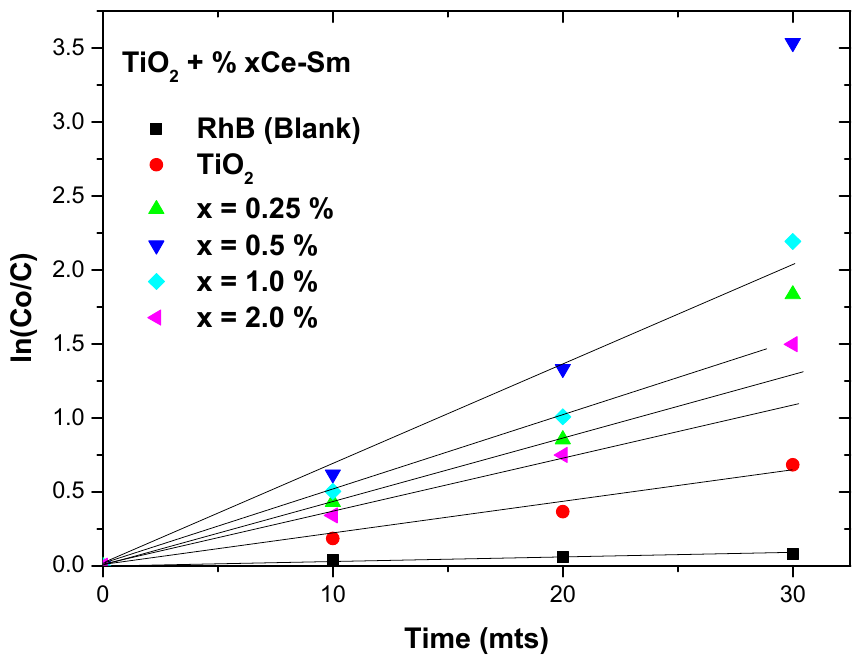
Figure 12. Kinetics simulation curve of Ce–Sm co-doped TiO 2 NPs ( x = 0.00, 0.25, 0.50, 1.00, and 2.00%).